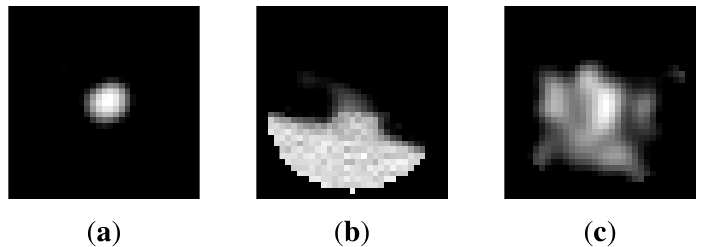
Figure 14. Extracted nodules. ( a ) example 1; ( b ) example 2; ( b ) example 3.